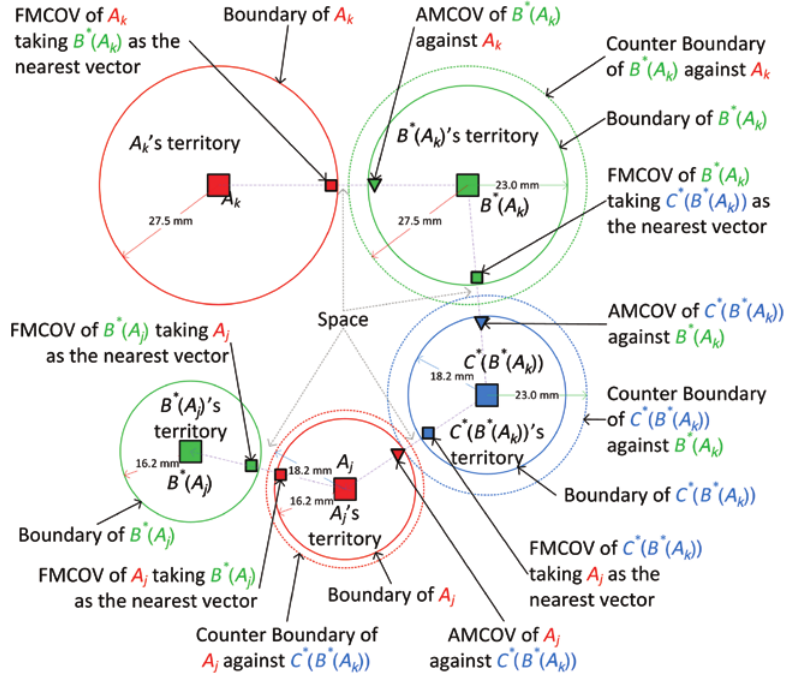
Figure 3: Instances (Big Rectangles), FMCOVs (Small Rectangles), AMCOVs (Small Triangles), Instances’ Boundary (Solid Circles), Instances’ Counter Boundary (Dotted Circles) in a Two-Dimensional Three-Class Data